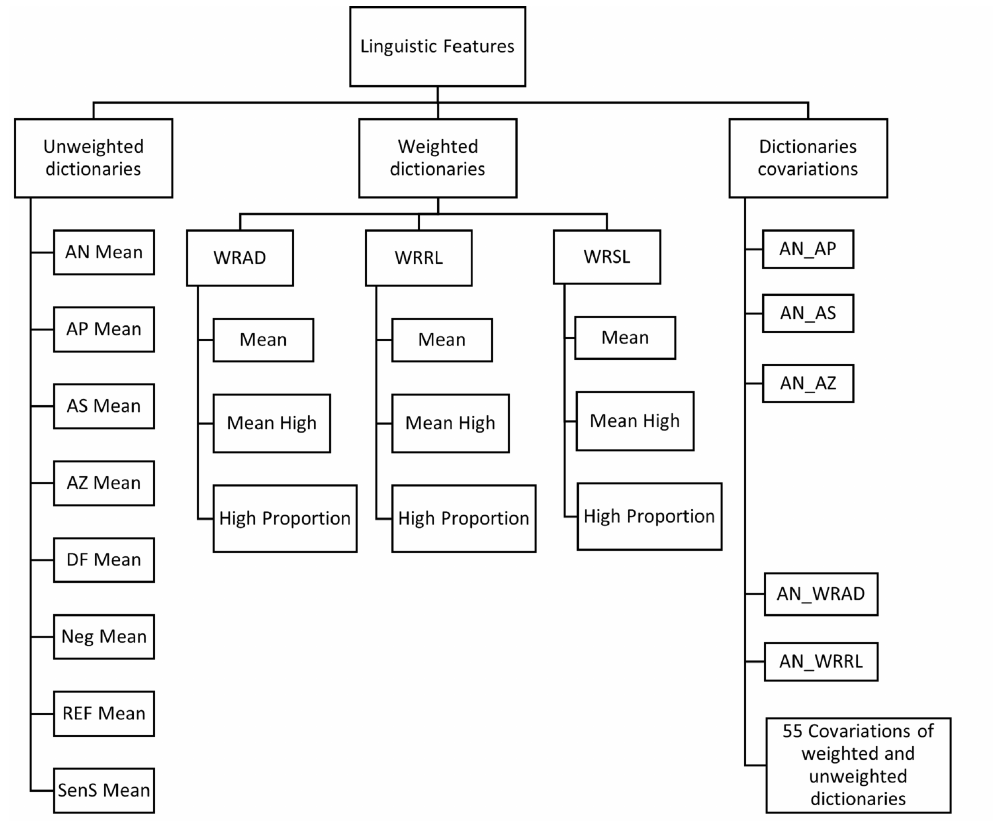
Figure 2. Extracted DAAP linguistic features tree